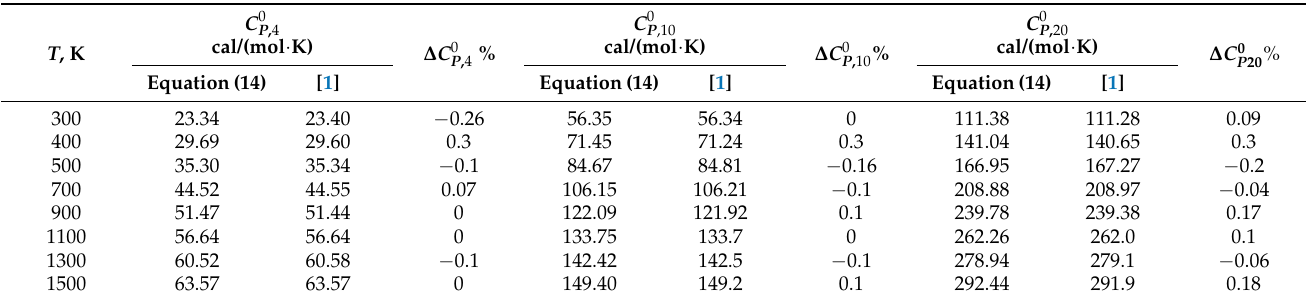
( T ) of n -C 4 H 10 , n -C 10 H 22 , and n -C 20 H 42 P